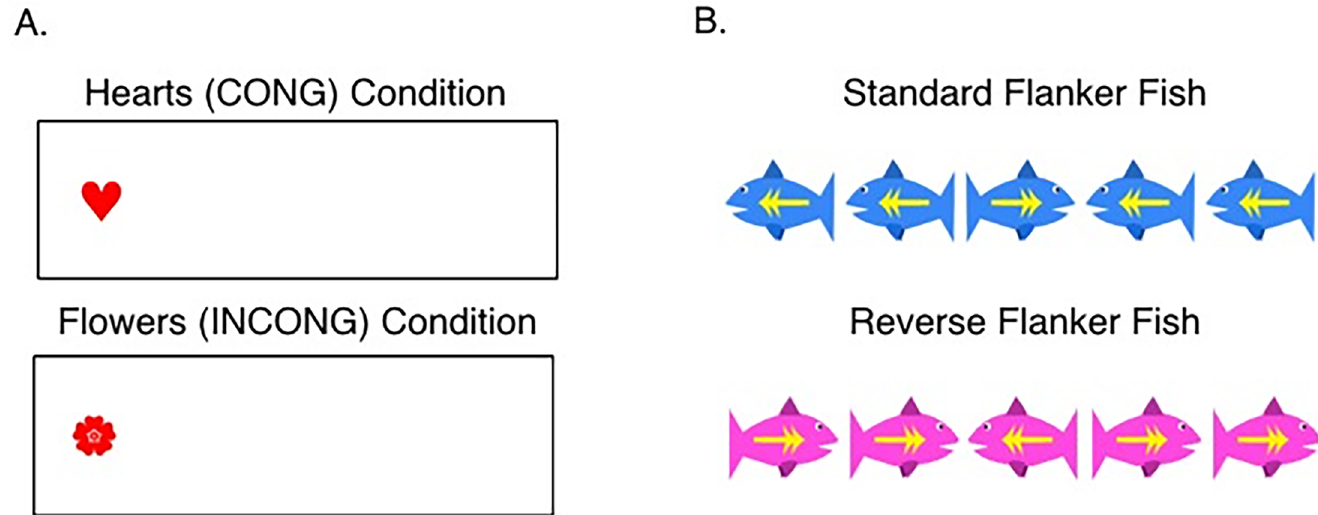
Fig 1. Heartsand Flowers and Flanker Fish tasks. (A) An exampleof a congruent,heart trial is on the top left, in which the child had to respondwith the arrow button that was on the same side of the image, and an exampleof an incongruent, flower trial is on the bottom left, in which the child had to respond with the arrow button on the oppositeside of the image. (B) An exampleof a trial in the standard conditionof the Flanker Fish task is on the top right, in which the child had to respondwith the arrow button corresponding to the directionof the middle fish, and an exampleof a trial in the reverse conditionis on the bottom right, in which the child had to press the arrow button correspondingto the directionof the